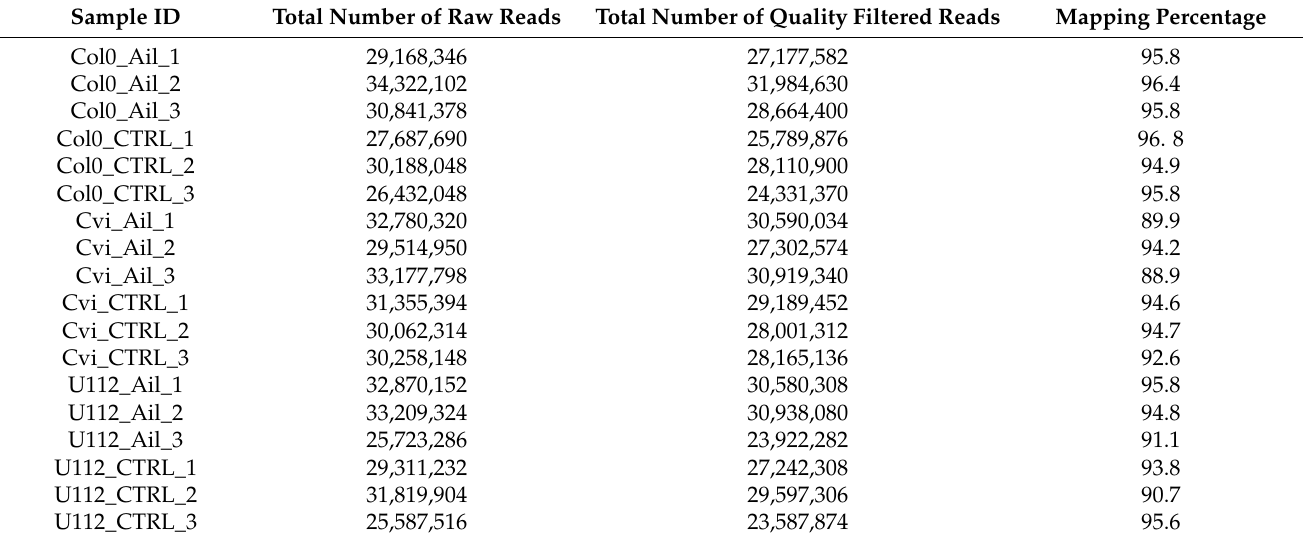
Table 1. Summary of RNA sequencing and genome mapping.